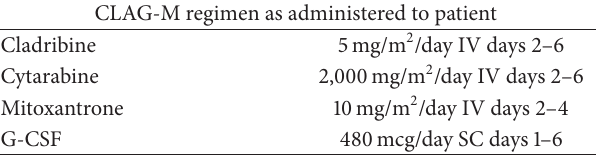
CLAG-M regimen as administered to